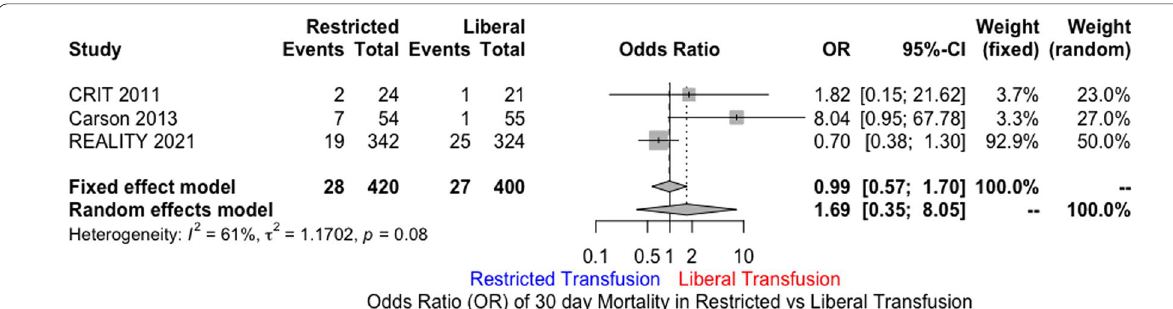
Fig. 1 Odds ratio of 30 day all-cause mortality. Values present are OR with 95% confidence interval, n , or percentage %. Restricted Liberal 10 g/dl ≤